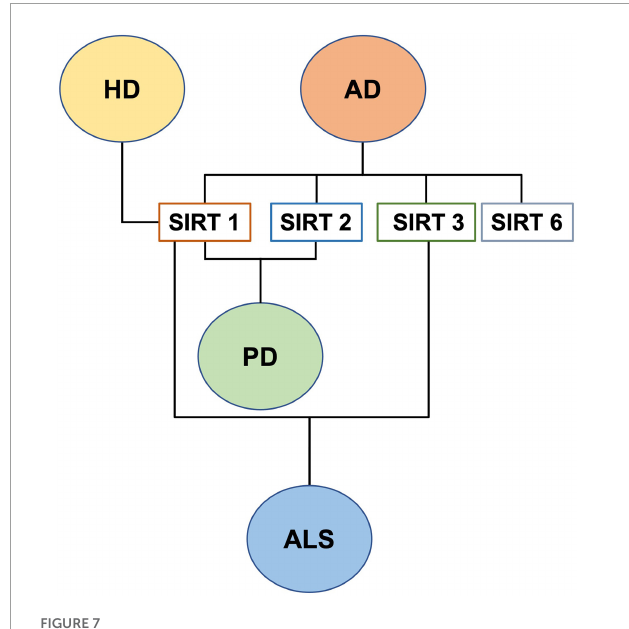
FIGURE7 SIRTs and neurodegenerative